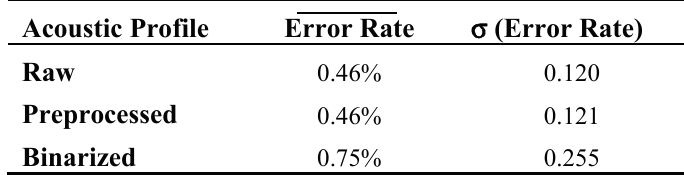
Table 7. Classification error rates for raw, preprocessed and binarized acoustic